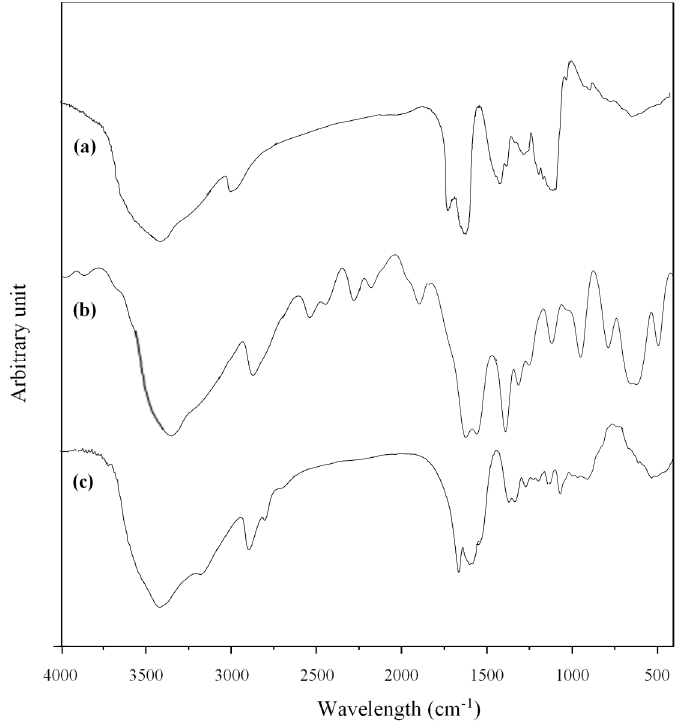
Figure 1. FTIR spectra of xanthan ( a ), polyacrylamide ( b ) and xanthan-g-polyacrylamide ( c